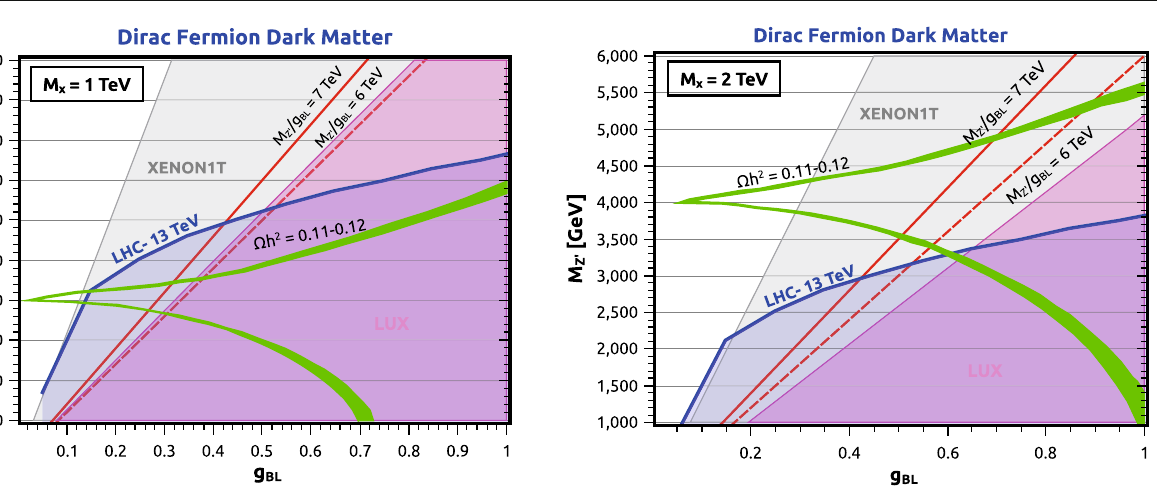
Fig. 9 Allowedregionofparametersfora1TeVDiracfermionasdark matter. The green curve delimits the region of parameter space with the right abundance ( (cid:2) h 2 = 0 . 11 − 0 . 12), the pink ( gray ) shaded region is ruled out by LUX2016 (XENON1T), the blue region is excluded by dilepton data from the LHC, and the solid red ( dashed ) lines rep- resent the current (old) LEP-II bounds, namely M Z (cid:2) / g BL > 7 TeV ( M Z (cid:2) / g BL > 6 TeV)